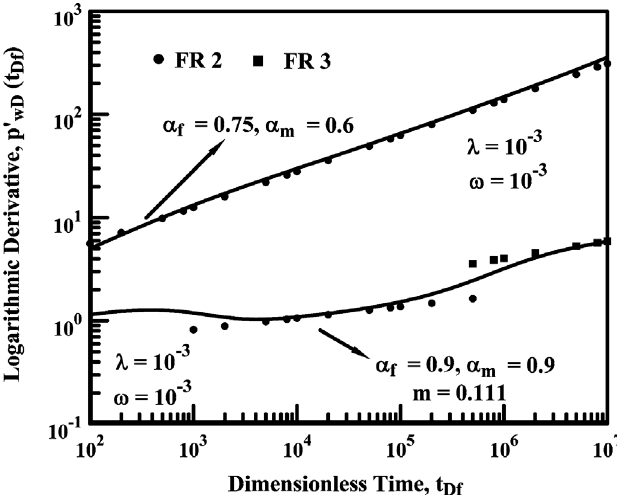
Figure 2. Logarithmic derivative responses corresponding to the results of Figure 1. The shapes of the responses for a m < 1 re fl ect the consequences of the lower effective